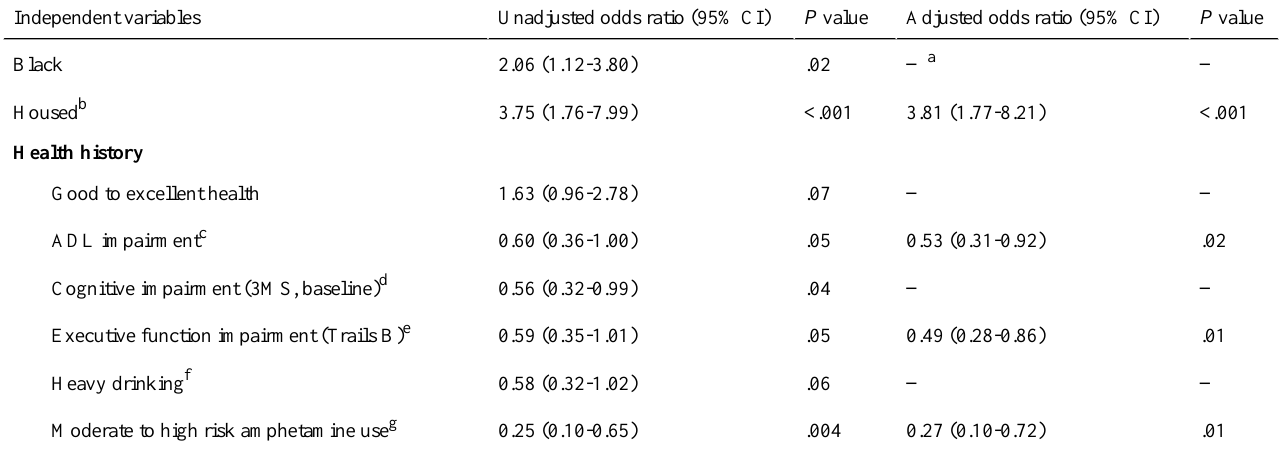
Table 5. Odds of current mobile phone